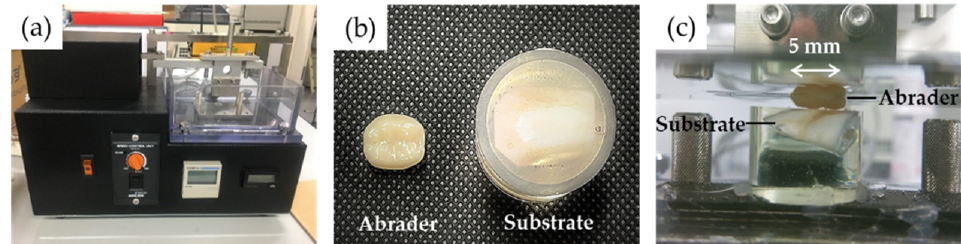
Figure 1. An abrasion tester ( a ), test specimens ( b ), and a two-body wear test ( c ).